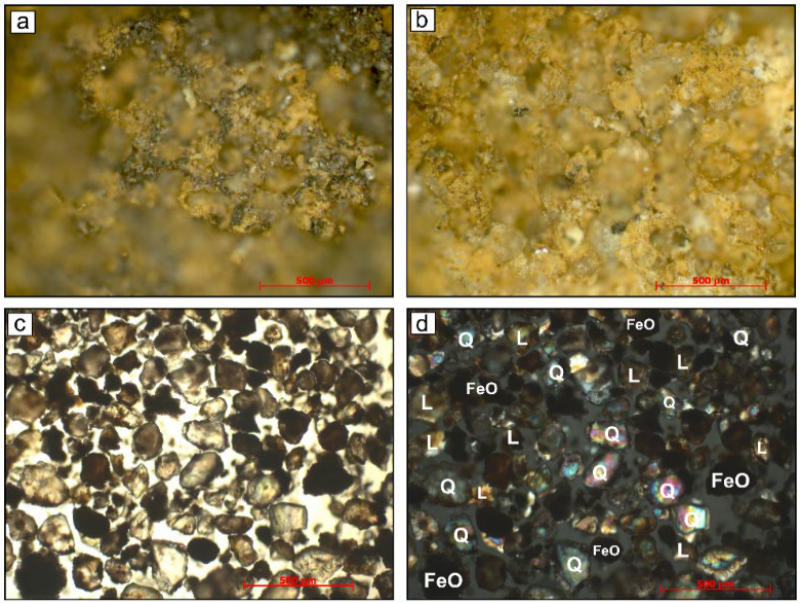
Figure 9. OM images of yellow pigment in reflection ( a , b ) and transmission ( c , d ) (50 and 100× magnification): Q—quartz; FeO—iron oxide; L—limonite ( c )—parallel Nicols; ( d )—crossed Nicols.